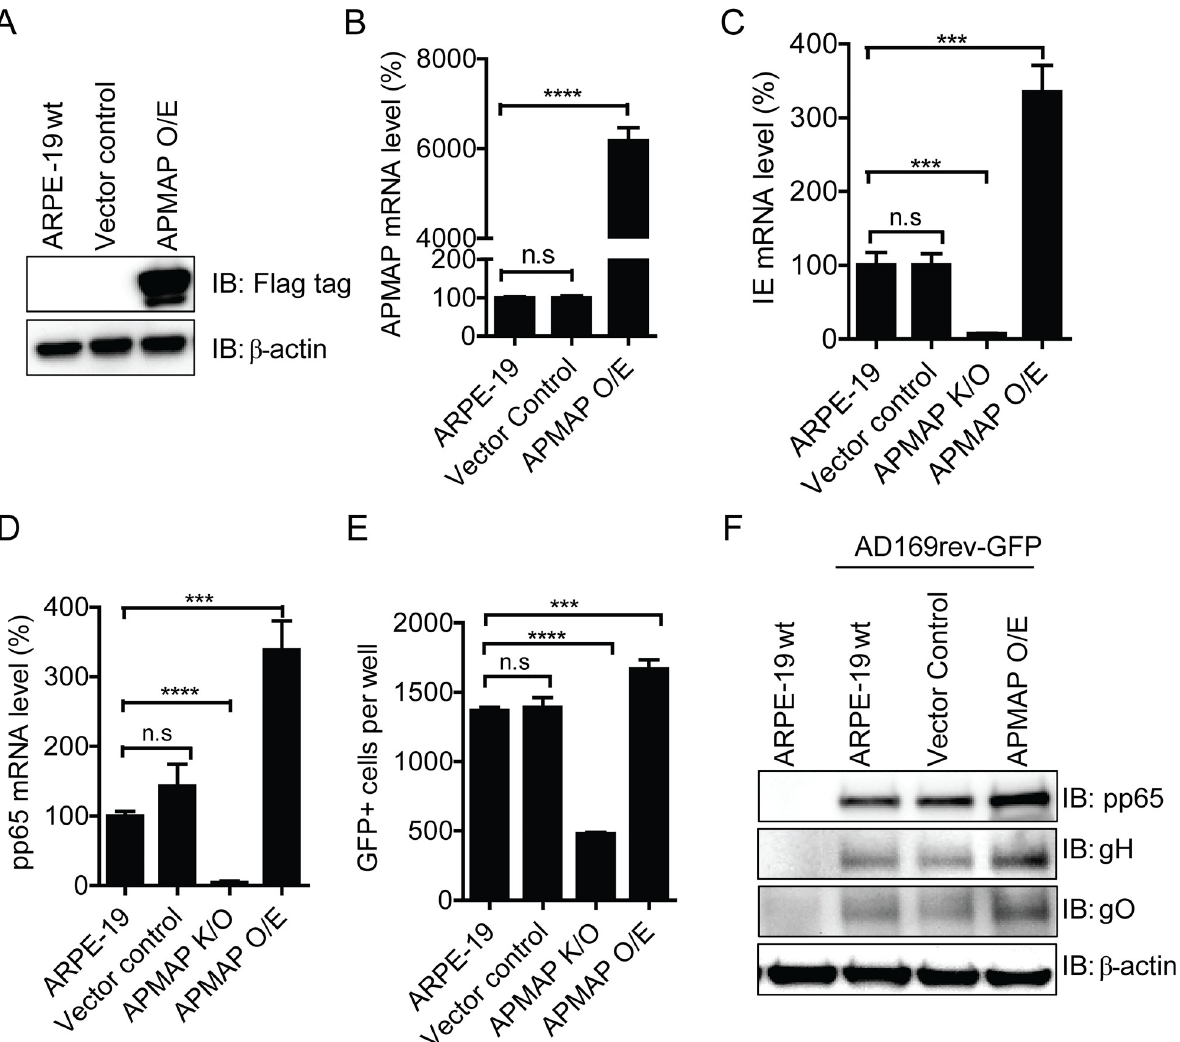
Fig 4. Enhanced AD169rev-GFP infection of ARPE-19 cells over expressing APMAP. ( A-B ) APMAP O/E stable cells were established by infecting ARPE-19 cells with lentivirus particles capable of expressing full length APMAP coding sequence with a Myc/Flag tag at C-terminus under puromycin selection. APMAP over expression in ARPE-19 cells were confirmed by ( A ) western blot using mouse mAb anti-Flag tag and ( B ) RT- qPCR, respectively. GAPDH served as internal control. ( C-E ) ARPE-19 APMAP K/O, APMAP O/E, and control cells were infected with AD169rev- GFP at MOI = 1.0 in 96-well plate. At 8 h after infection, the cells were collected for RNA extraction and RT-PCR to detect ( C ) HCMV IE mRNA level and ( D ) pp65 mRNA level, respectively, and shown as percentages to that infected ARPE-19 cells, with GAPDH mRNA served as internal control. No significant signal for IE and pp65 mRNA in mock-infected cells could be detected by the primers and thus was not shown. Data analysis was performed using the 2 - ΔΔ CT method. The data are shown as relative IE or pp65 mRNA level to that of infected wildtype cells. The black bars represent means ± SD of replicate wells. ( E ) In another infection experiment, the plate was read by C.T.L. Immunospot machine at 48 h post infection. Number of GFP positive cells were counted automatically using the software. The data are shown as means ± SD of total number of GFP positive cells per well for triplicate wells. The APMAP mRNA level (%), IE mRNA level (%), or number of GFP+ cells in vector contol, APMAP K/O and APMAP O/E cells were compared individually to that of wildtype MRC-5 cells using unpaired two-tailed student t-test for significance analysis. ( F ) At 72 h after infection, the cells were collected to detect HCMV protein expression by western blot, using anti-pp65, anti-gH and anti-gO antibodies, respectively. β -actin served as loading control. overexpression of full length human APMAP with a C-terminal Myc/Flag-tag. Over expression of APMAP protein was confirmed by blotting with both APMAP and the flag tag specific anti- bodies ( Fig 5A ). Interestingly, the number of GFP positive cells significantly increased in APMAP O/E cells than in control cells at 48 h post infection by either AD169-GFP or